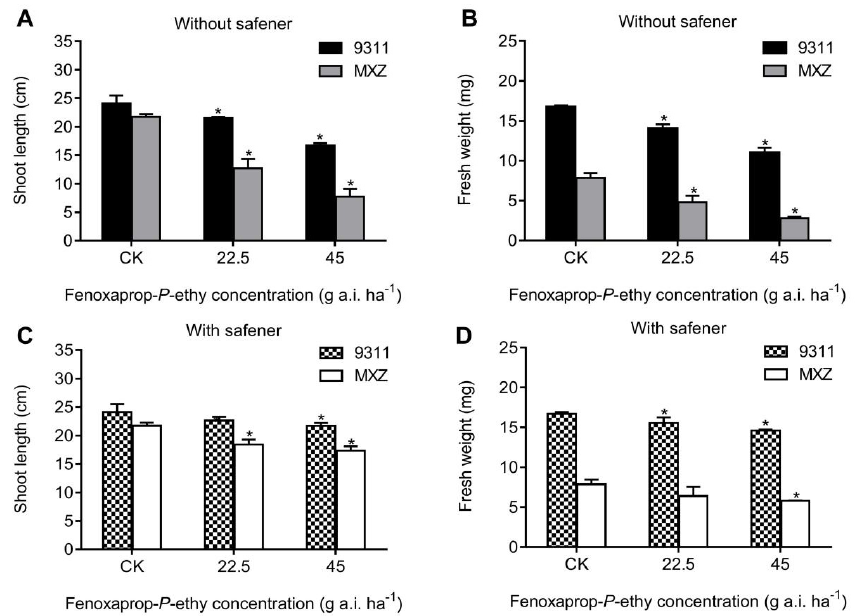
Figure 1. Shoot length and fresh weight in rice 9311 and MXZ exposed to fenoxaprop-P-ethyl alone or in combination with isoxadifen-ethyl hydrolysate 7 days after treatment. ( A ) Shoot length in rice exposed to fenoxaprop-P-ethyl alone; ( B ) Fresh weight in rice exposed to fenoxaprop-P-ethyl alone; ( C ) Shoot length in rice exposed to fenoxaprop-P-ethyl combination with isoxadifen-ethyl hydrol-ysate; ( D ) Fresh weight in rice exposed to fenoxaprop-P-ethyl combination with isoxadifen-ethyl hydrolysate. * indicates a significant difference between different concentrations of fenoxa-prop-P-ethyl and untreated control within each biotype according to Duncan’s test ( p ≤ 0.05).